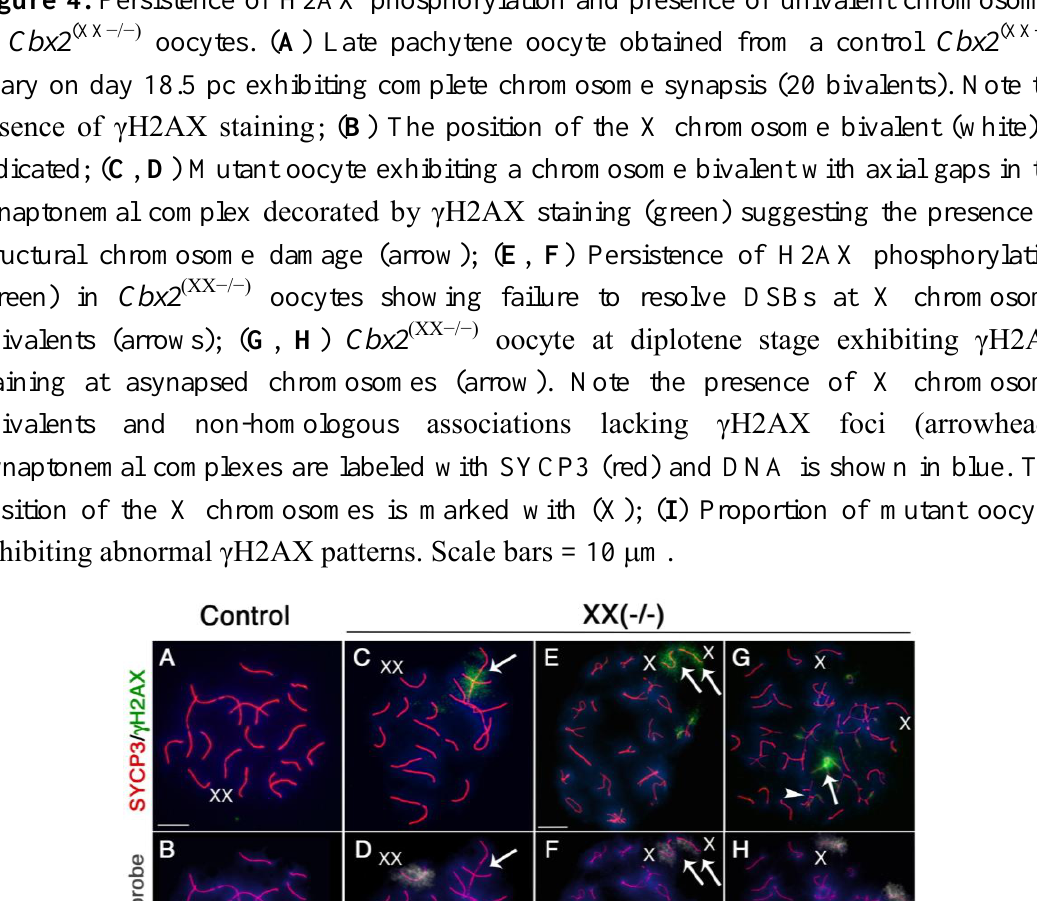
Figure 4. Persistence of H2AX phosphorylation and presence of univalent